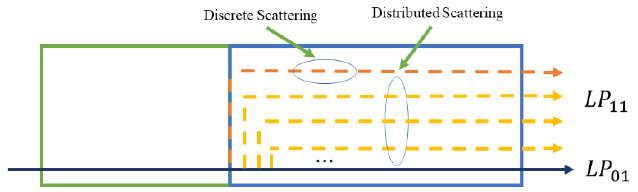
Figure 10. Discrete scattering and distributed scattering.